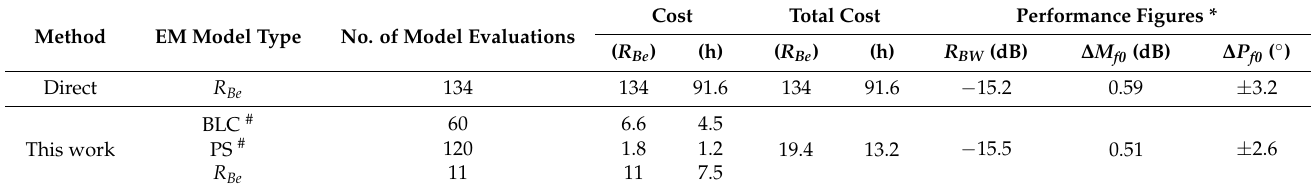
Table 2. Butler matrix 1: numerical benchmark of the proposed design